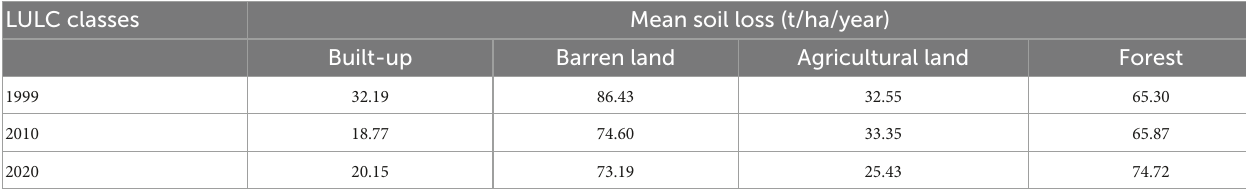
TABLE 8 Mean soil loss in different LULC classes for the years 1999, 2010, and 2020. LULC